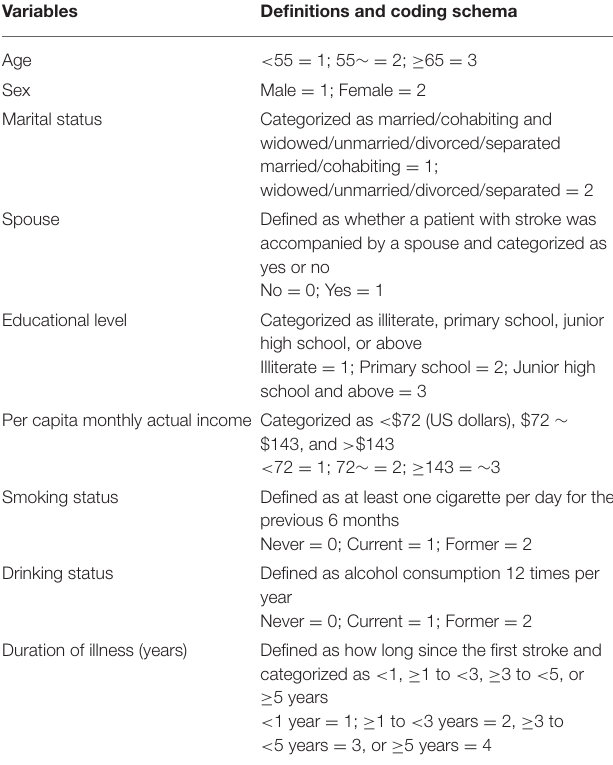
TABLE 1 | Definitions and coding schema for patients with stroke’ sociodemographic variables.